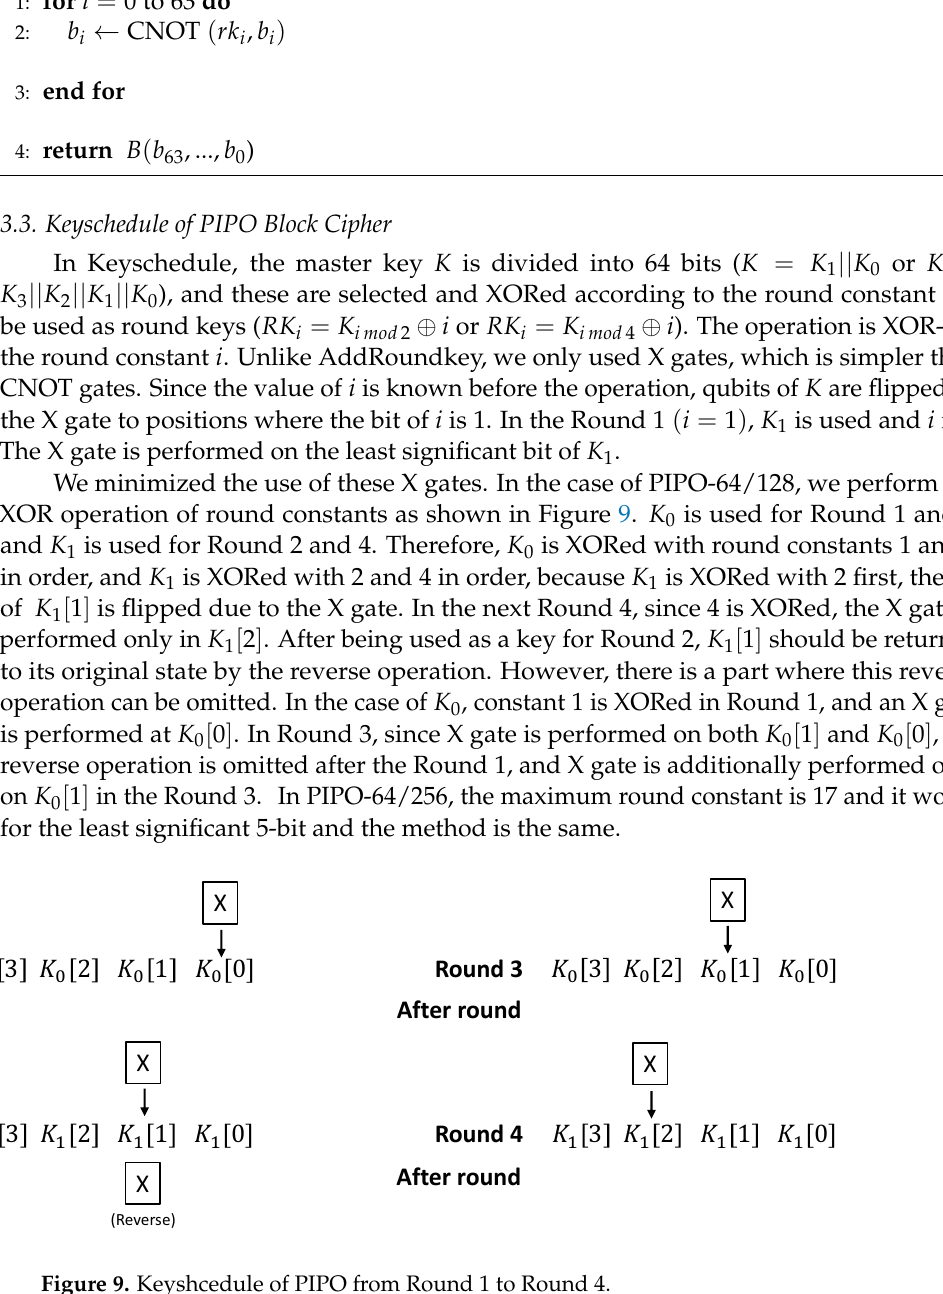
Figure 9. Keyshcedule of PIPO from Round 1 to Round